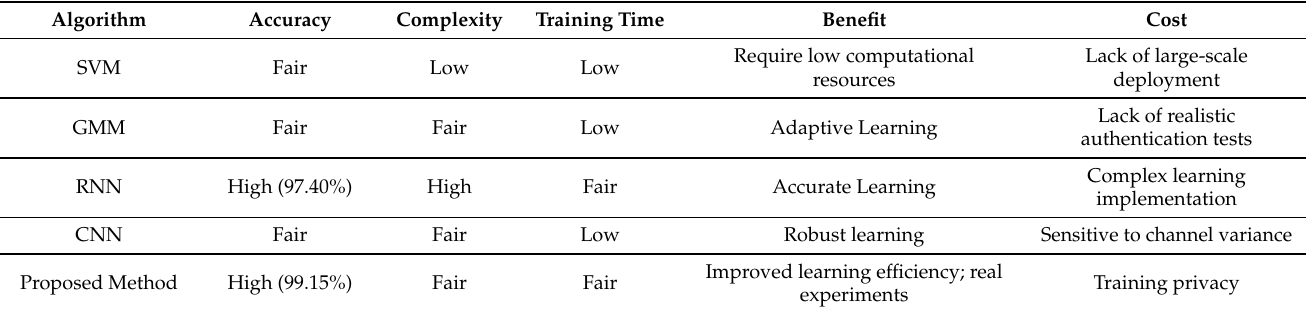
Table 6. Taxonomy of detecting malicious attacker use